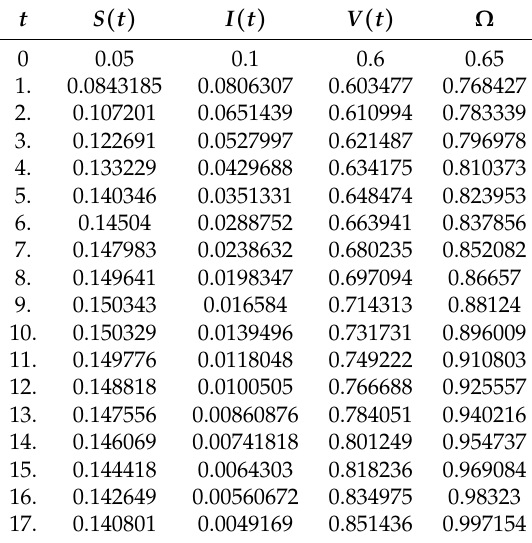
Figure 3. Population fraction verses time for Case 3: α 1 = α 2 = α 3 = 0.5. Table 5. α 1 = α 2 = α 3 =